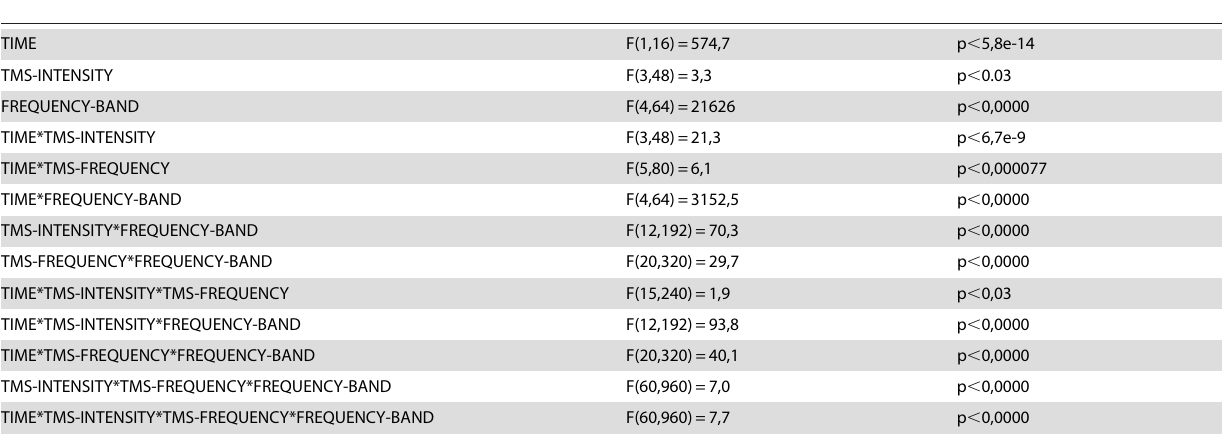
Table 1. Results of the repeated measures ANOVA: full factorial general linear model.